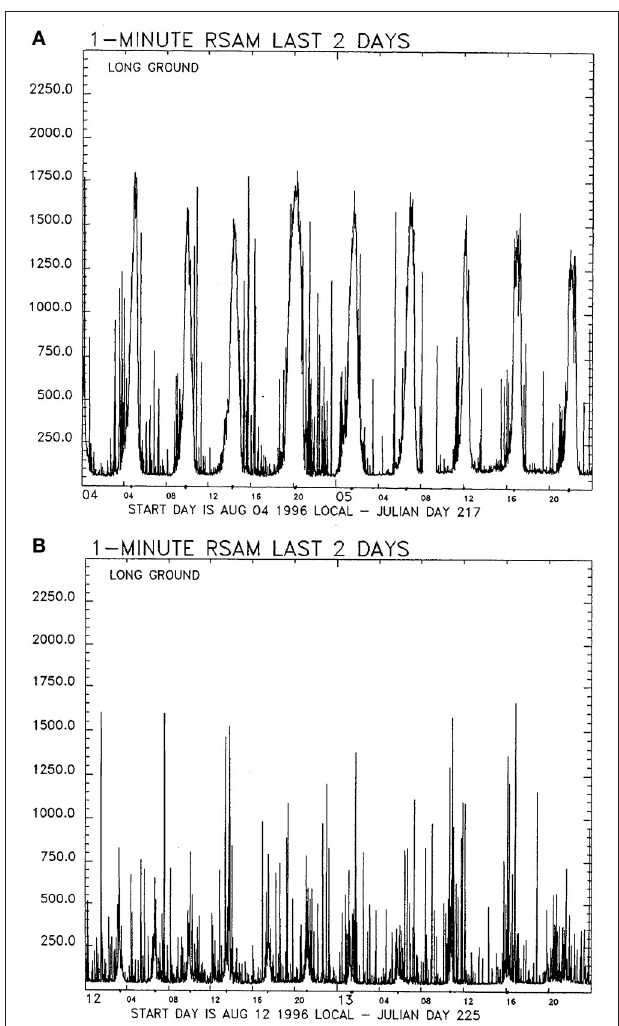
FIGURE 4 | Banded tremor at Soufrière Hills volcano in August 1996. The vertical scale is RSAM units at the Long Ground seismic station ∼ 2 km northeast of the volcano’s summit. (A) Tremor on 4–5 August. Note the maximum RSAM value of 1800 and the ∼ 5-h spacing of tremor bands. (B) Tremor on 12–13 August. The maximum RSAM has declined to 1650, and the tremor bands are now spaced at intervals of 3–4h. Data kindly provided by the Montserrat Volcano Observatory.